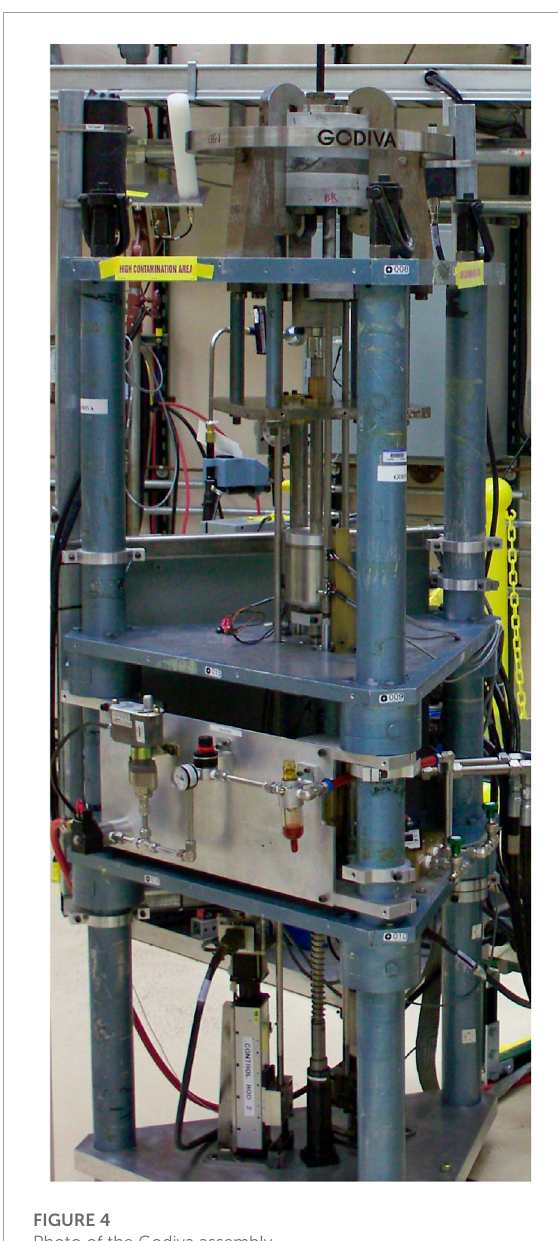
FIGURE 4 Photo of the Godiva assembly.